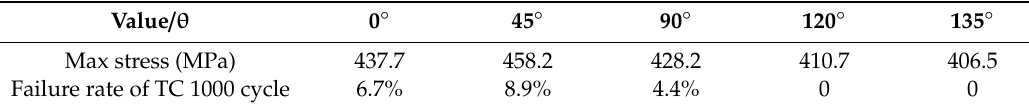
Figure 8. Stress distribution of pad in one TC cycle. Table 3. The max von Mises stress of different UBM design. Table 3. The max von Mises stress of di ff erent UBM design.